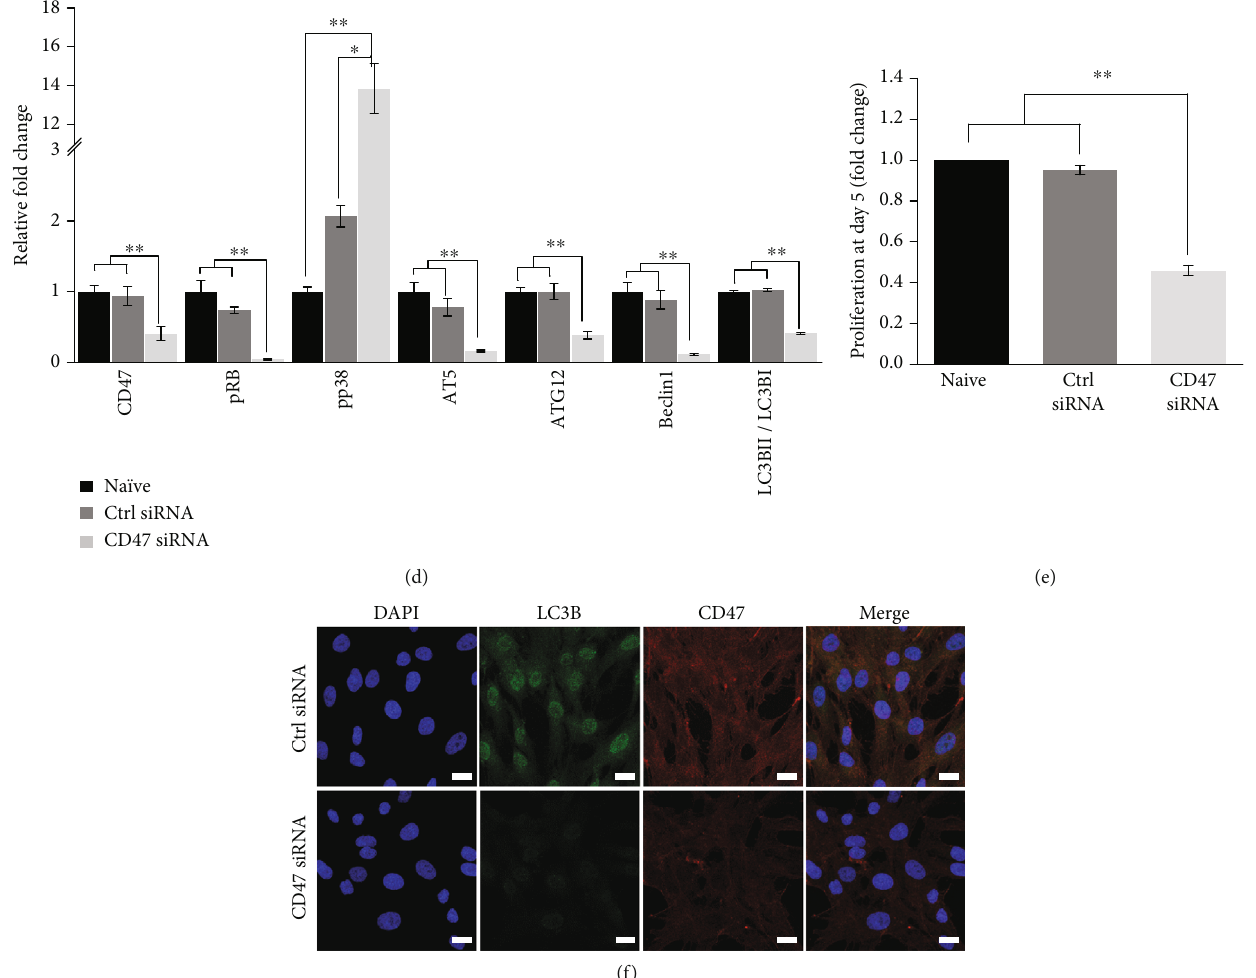
Figure 4: CD47 knockdown in UCB-MSCs reduces the autophagy and accelerates the senescence. (a) Flow cytometric analysis showed CD47-silenced UCB-MSCs downregulated CD47 cell surface markers at passage 6. (b) Human autophagy array was performed to reveal the signi fi cant autophagy-related protein level di ff erence between control and CD47-silenced UCB-MSCs. Relative fold changes were normalized to control siRNA-transfected cells. Red box with arrow indicated LC3B proteins, showing signi fi cant di ff erence. (c, d) Representative western blot analysis demonstrated relative changes of senescence-related proteins (pRB and pp38) and autophagy-related proteins (ATG5, ATG12. Beclin1, and LC3B) after CD47 siRNA transfection at passage 6. (e) Proliferation at day 5 after CD47 siRNA transfection was downregulated. (f) Immunostaining results with LC3B and CD47 antibodies on control siRNA and CD47 siRNA- transfected UCB-MSCs were determined. Scale bar 20 μ m. Data is expressed as mean ± SD ; n = 3 ; ∗∗ p < 0 : 01